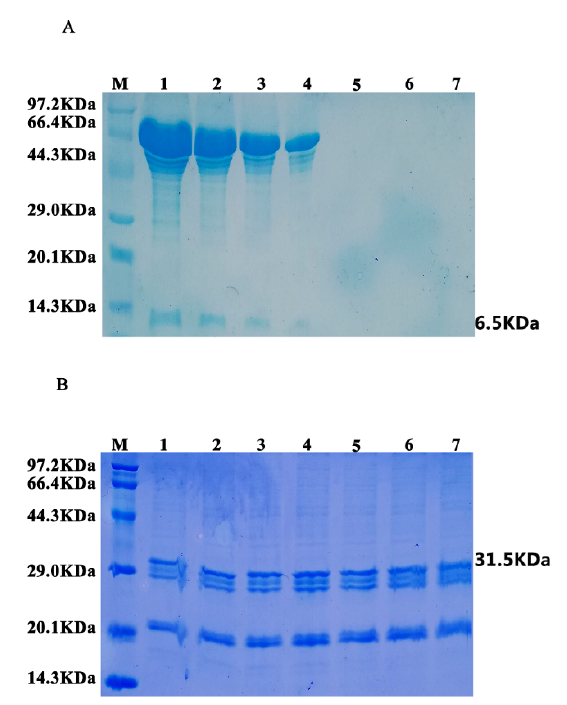
Figure 4. Analysis of hEGF protein and oleosin–hEGF–hEGF activation stability. ( A ) SDS-PAGE analysis of hEGF standard protein digested with protease at different times; ( B ) SDS-PAGE analysis of oleosin–hEGF–hEGF digested with protease at different times; (M) protein marker, 1–7—hydrolyzed protein of 0, 10, 15, 30, 45, 60, 90 min.